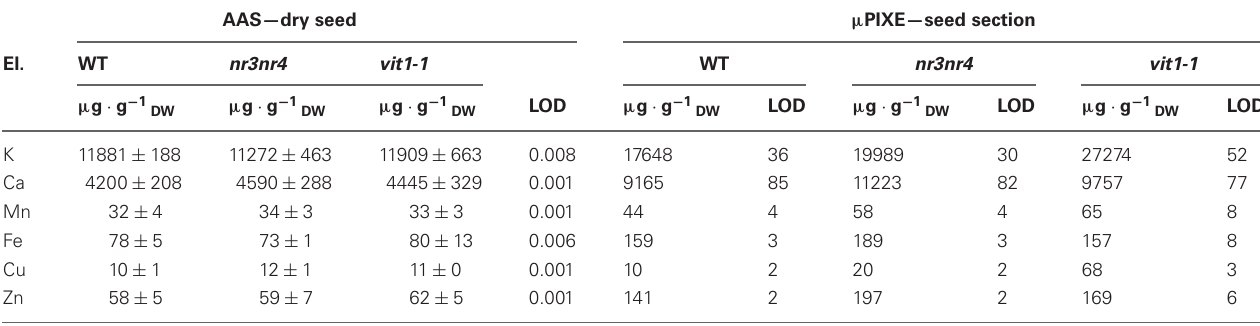
AAS of bulk samples. Values are means ± SE (n = 3–4 dry seed batches for each genotypes). X-ray and RBS spectra of the whole seed section were selected using RISMIN software and analysed using SIMNRA and GUPIX softwares. Concentrations of one representative measured sample are presented; LOD, limit of detection of the measurements ( µ g · g − 1 DW ).